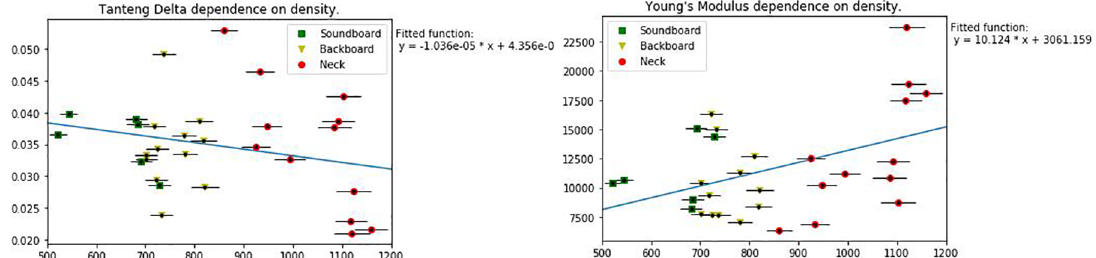
Figure 7. Curve fit of mechanical properties dependence on density for all species and their uses in acoustic